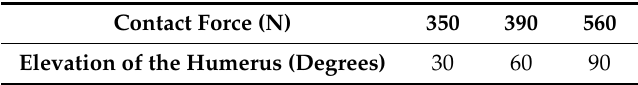
Table 3. The applied force to the glenosphere as a function of the elevation angle of the humerus in the case of individual 2.